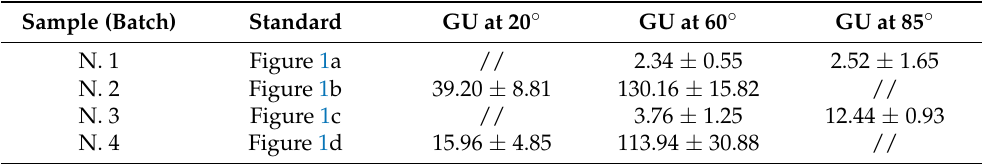
Table 4. Gloss values of the sample batches at different angles (20 ◦ , 60 ◦ , and 85 ◦ ) according to ASTM D523-14 (Standard Test Method for Specular Gloss)